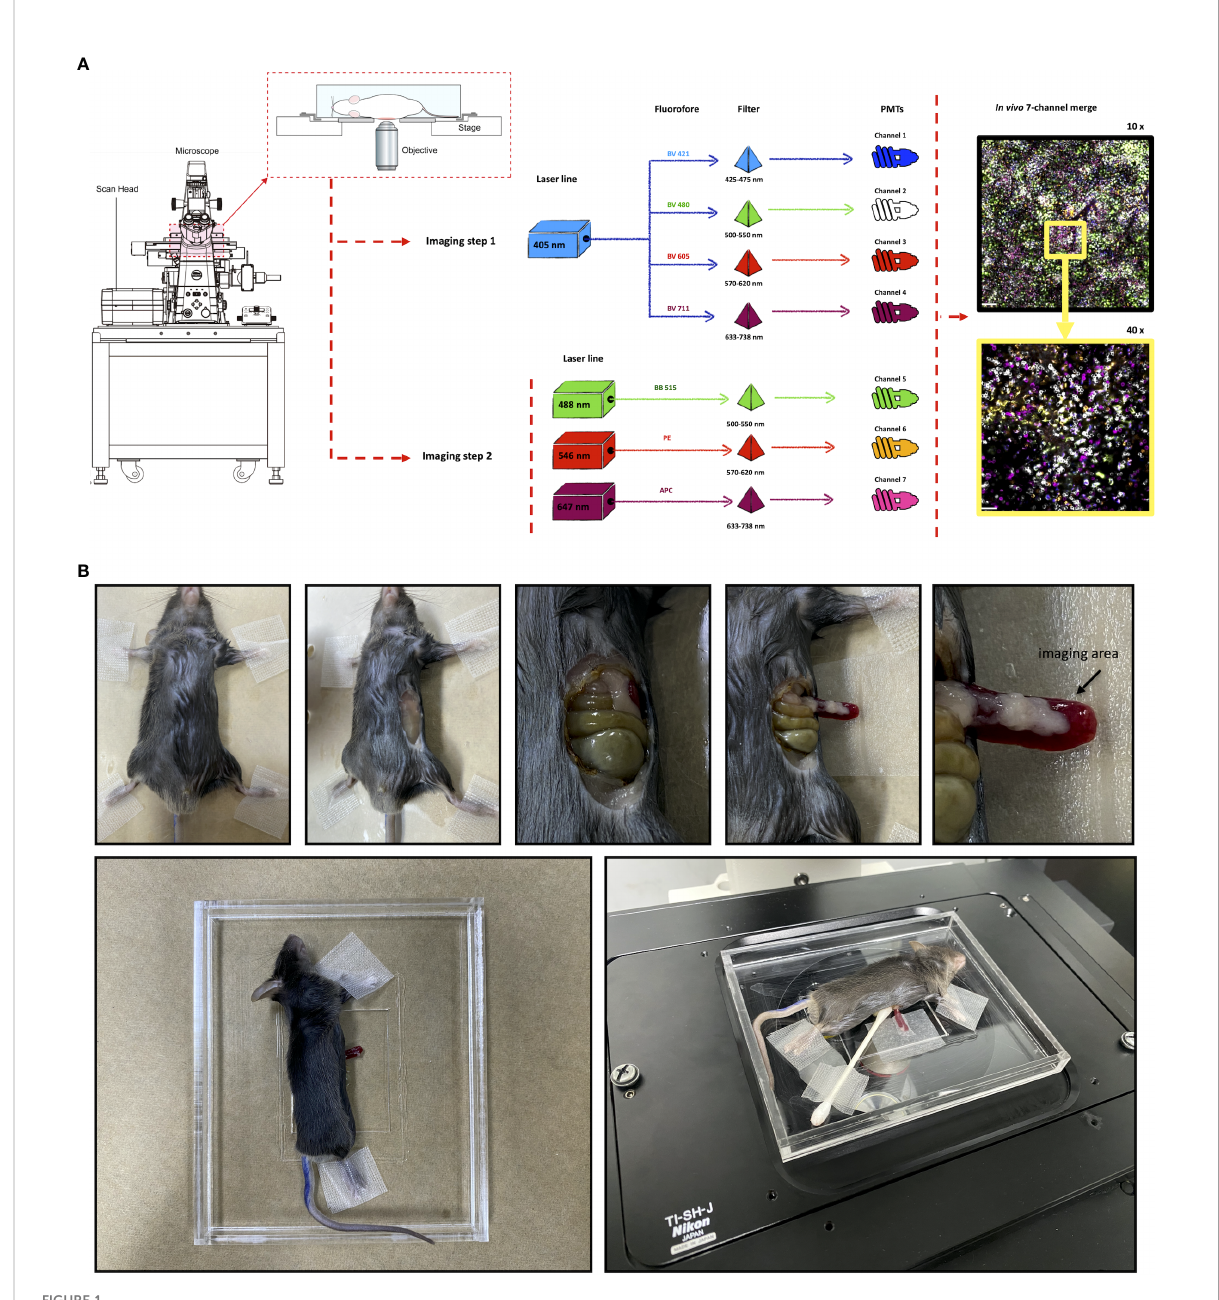
FIGURE 1 Novel microscope imaging setup and selected fl uorophores allow seven channel intravital imaging acquisition. (A) Schematic diagram summarizing the new protocol used to identify a wide range of immune cells in vivo . (B) Detailed surgical procedure for spleen imaging using confocal intravital